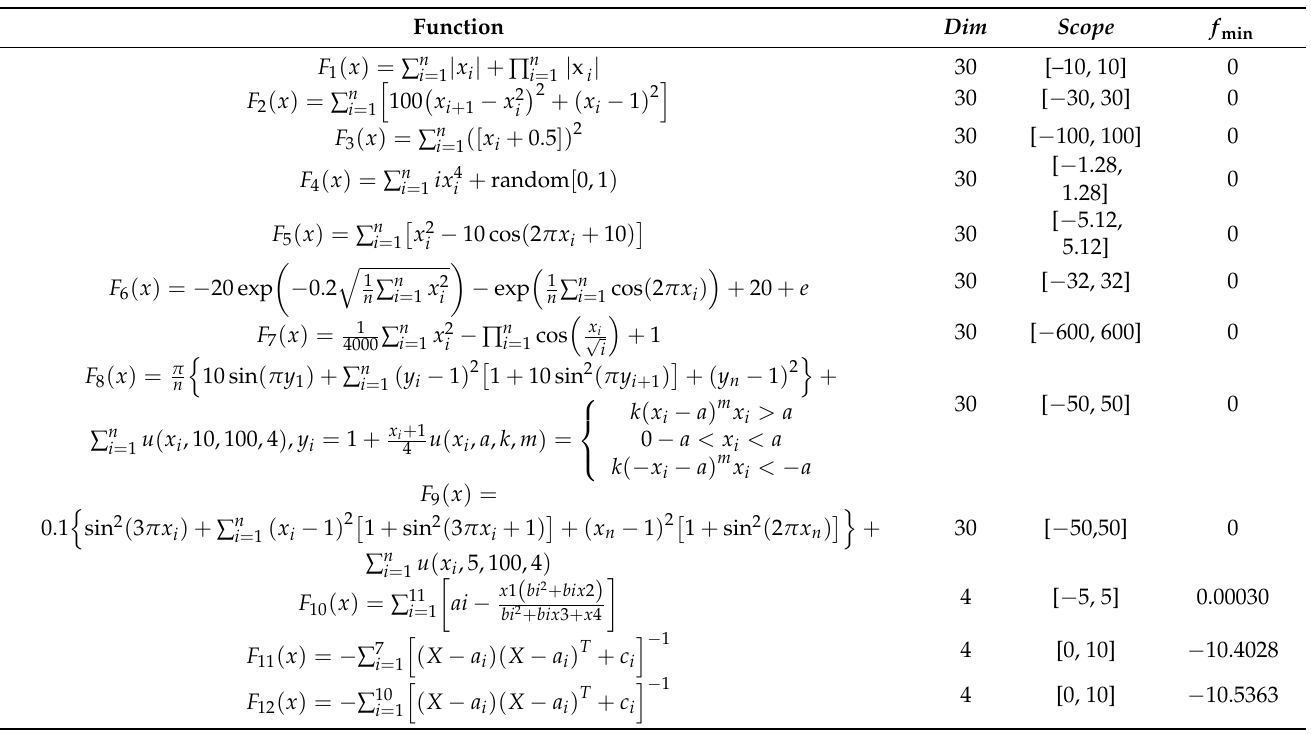
Table 2. Basic information of benchmark functions. Function